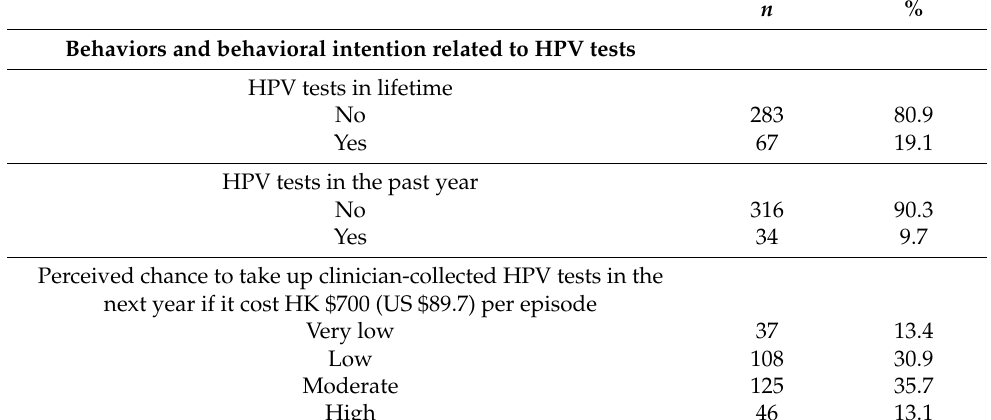
Table 2. Variables related to human papillomavirus (HPV) tests among the participants ( n = 350).